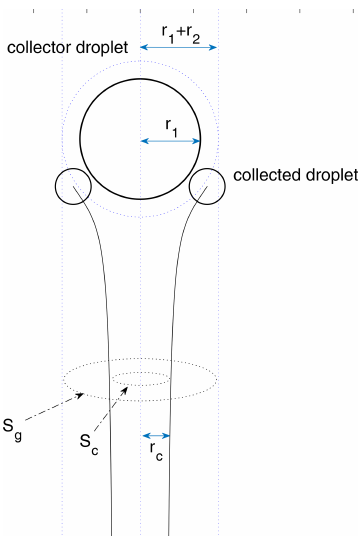
Figure 1. A schematic diagram for a droplet pair collision. The ini- tial vertical distance between the center of the two droplets is set to be 30 ( r 1 + r 2 ), which approximates two droplets initially sepa- rated by an infinite distance. To calculate the collection cross section S c = πr 2 c , the initial horizontal distance needs to be changed with the bisection method until it converges to r c . Collision happens only when the initial horizontal distance is smaller than r c